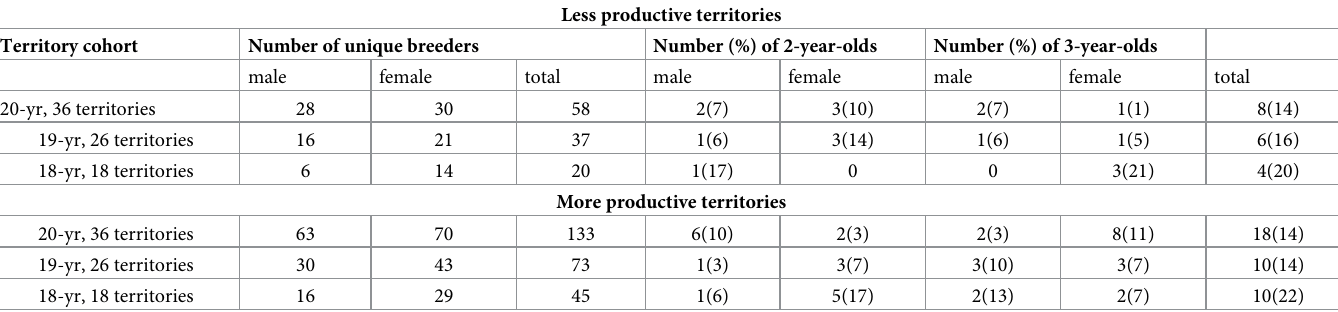
Table 6. No differences in the proportion of 2- or 3-years-old breeders in the less productive than more productive